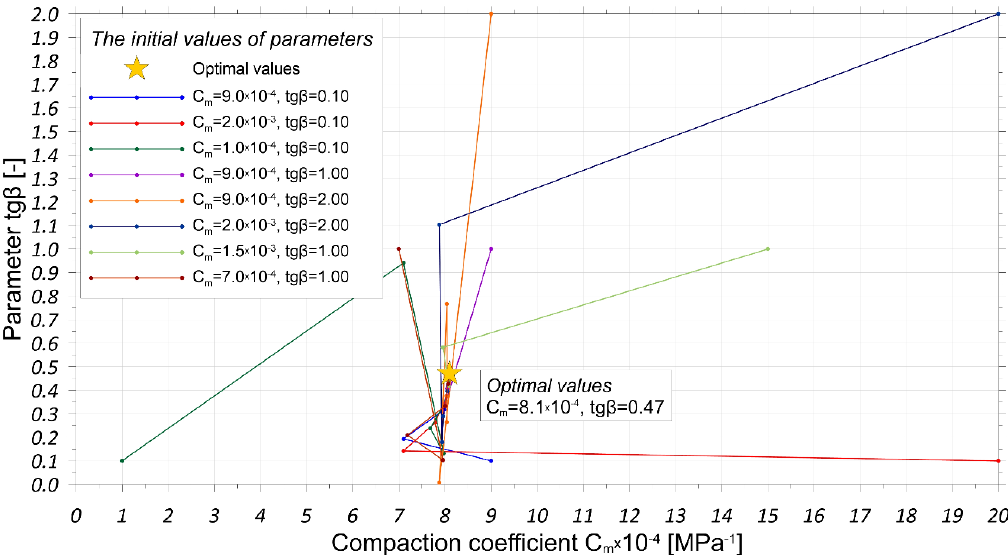
Figure 4. Determination of optimal parameter values related to different initial conditions. The testing was carried out for modeling data; optimal parameters are represented by a star on the graph. The iterations are represented by colored dots on each track.